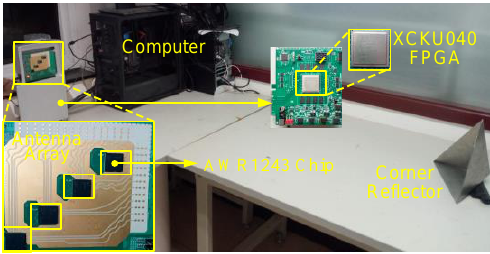
Figure 9. The experimental device of DBF for the MIMO millimeter wave radar.